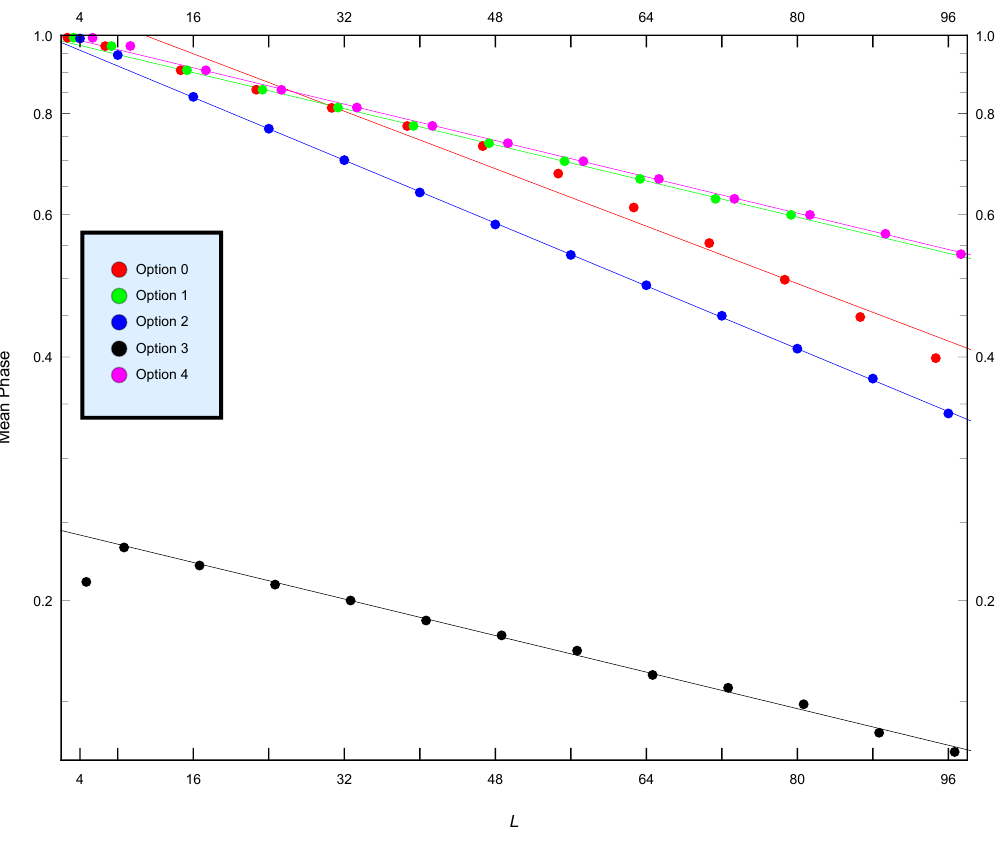
Figure 8 . The mean phase as a function of lattice size on a logarithmic scale for the di(cid:11)erent options for resolving the numerical stability of contour 4 together with their linear least square (cid:12)ts. The various options are colour marked and are separated horizontally for